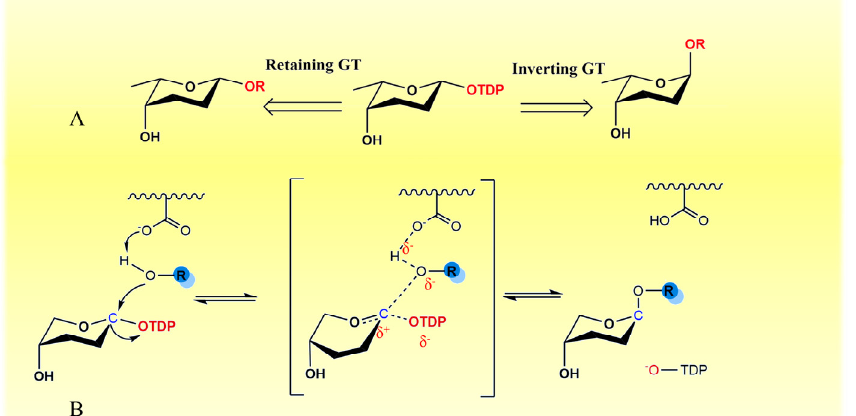
Figure 5. Catalytic mechanisms of glycosyltransferases. ( A ) Reaction mechanism of inverting and retaining glycosyltransferases; ( B ) Inverting glycosyltransferase by a direct-displacement S N 2-like reaction mechanism.